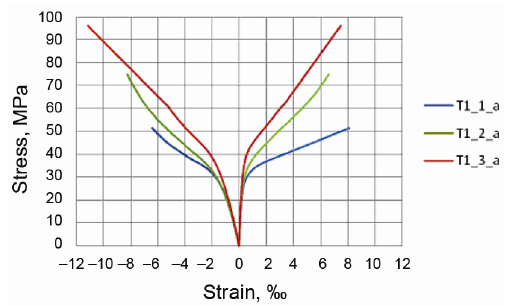
Fig. 7. Monotonic stress-strain curves for T 1_1_a, T 1_2_a and